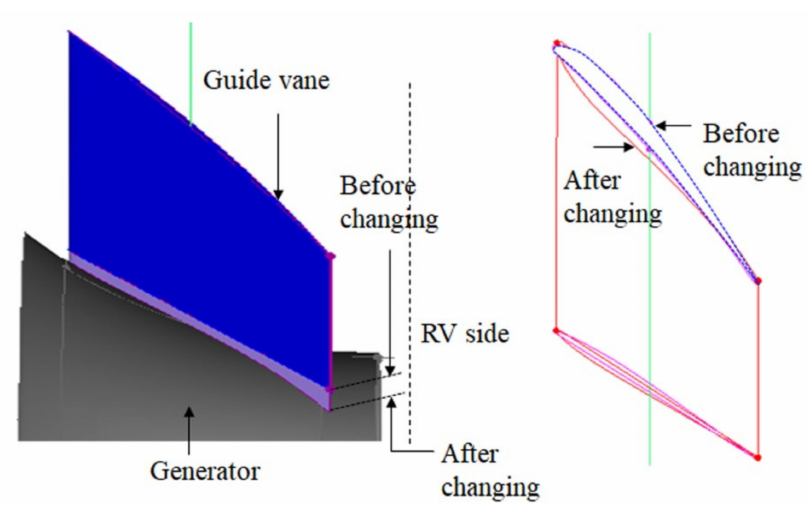
Figure 22. Changing the shape of guide vanes with short chords to make them streamlined.